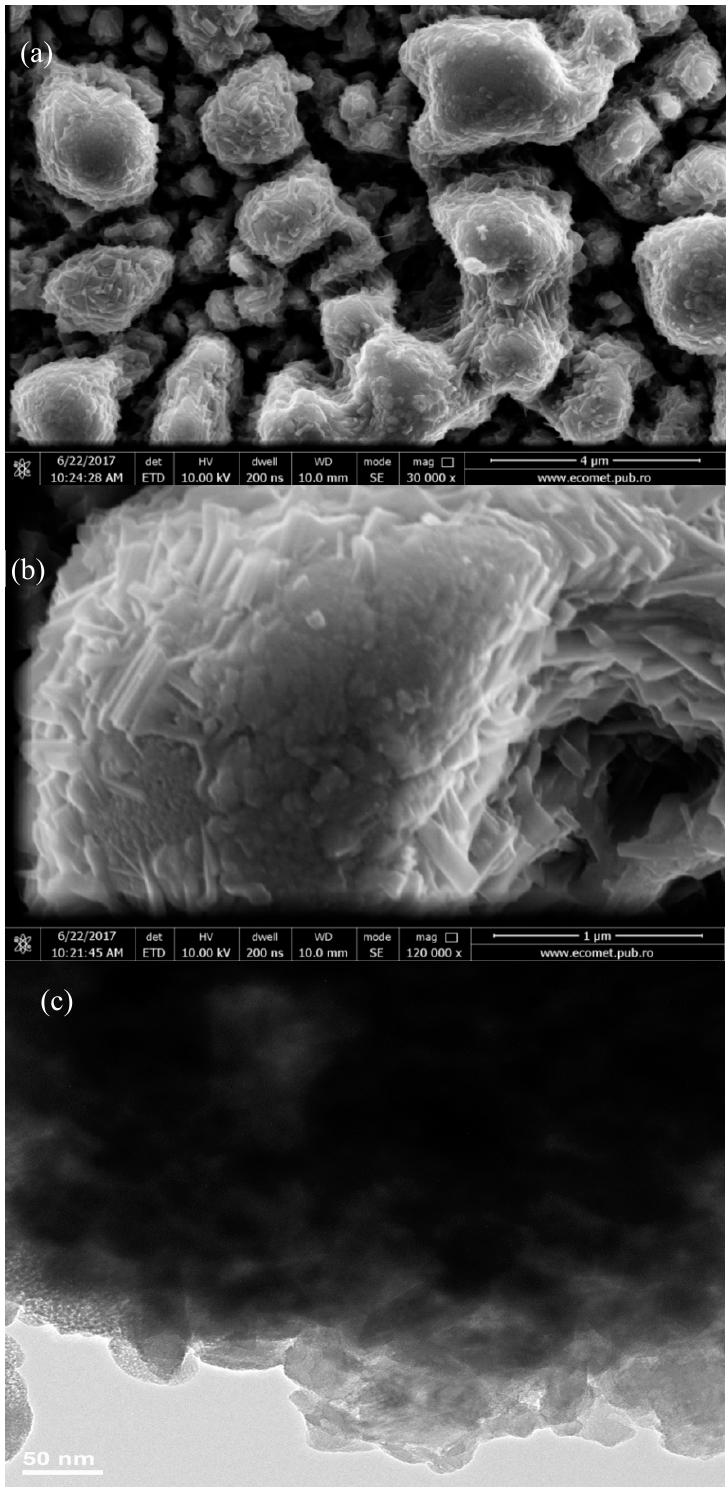
Figure 4. SEM images at 30,000× ( a ) and 120,000× ( b ) magnifications and TEM images ( c ) of the codoped MoO 3 : Fe 2%-Co 1% thin films.